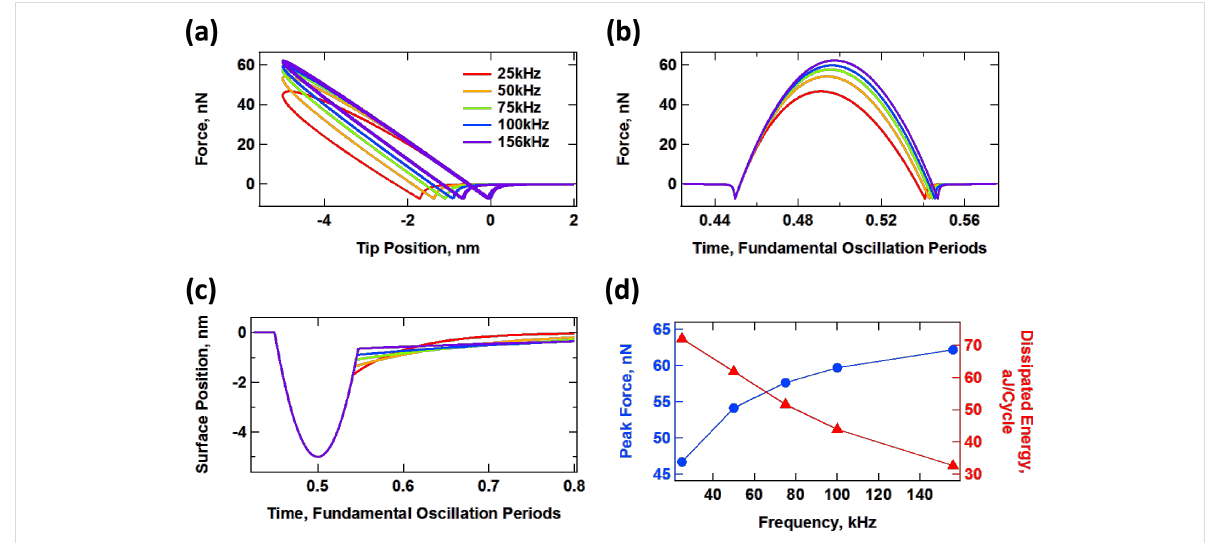
Figure 4: Interaction of an SLS surface with a probe oscillating along a perfectly sinusoidal trajectory given by z tip ( t ) = 95 nm + (100 nm)·cos( ω t ), where ω is equal to 2 π times the frequency indicated in the graphs (the relaxed surface is initially located at a height of zero). (a) Force–distance tip trajectory (the trajectory proceeds in the counterclockwise direction); (b) tip–sample force vs normalized time; (c) surface recovery vs normalized time; (d) peak force and dissipated energy per cycle vs cantilever frequency (the two traces are color coded with their respective axes). The SLS parame- ters were K inf = K o = 7.5 N/m and C diss = 1 × 10 − 5 N·s/m. The time axes in (b) and (c) have been normalized by the respective fundamental period for each